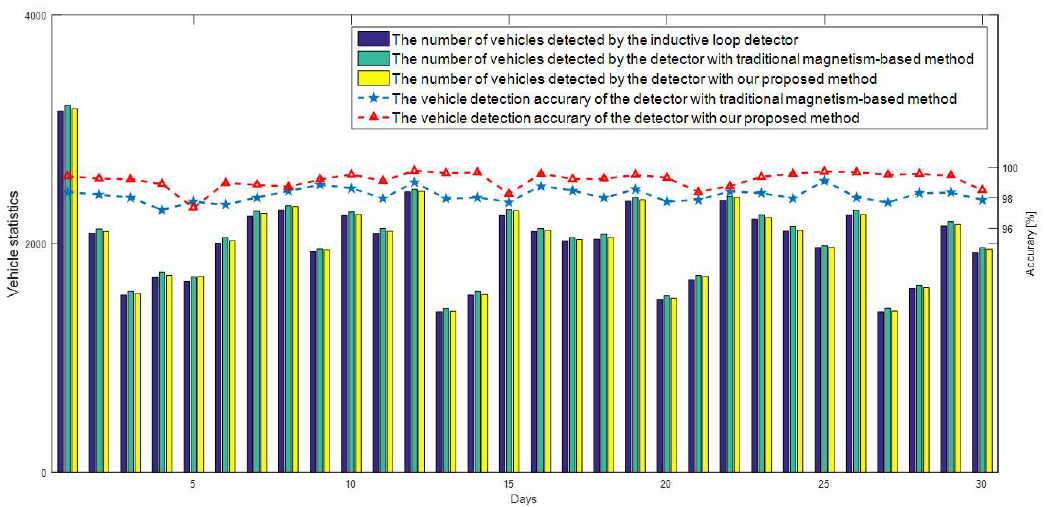
Figure 6. Long-term vehicle statistics and accuracy comparison.